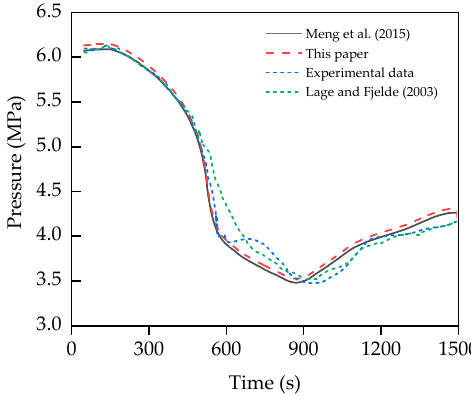
Figure 12. Bottom hole pressure vs. time (605 m).